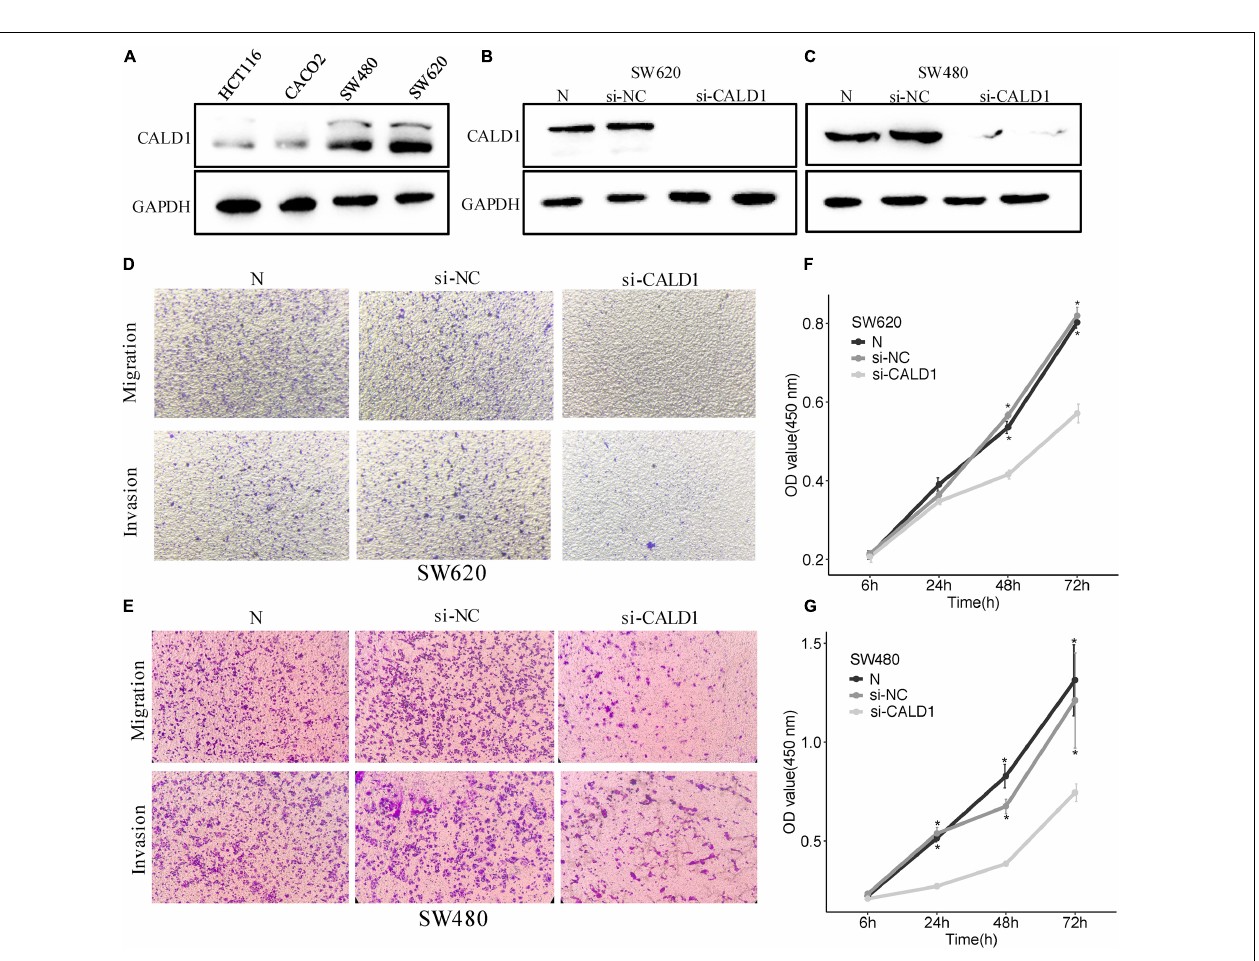
FIGURE 8 | CALD1 promotes cell proliferation, migration, and invasion in CRC cells. (A) The protein levels of CALD1 in four kinds of CRC cell lines were measured by Western blot. (B,C) The protein levels of normal, si-NC, and si-CALD1 transfected SW620 (B) and SW480 (C) cells by Western blot; si-CALD1 transfections were performed in duplicate. (D,E) Transwell assays revealed that CALD1 knockdown attenuated SW620 (D) and SW480 (E) cell migration and invasion. (F,G) CCK8 assays were performed to assess cell viability in normal, si-NC, and si-CALD1 transfected SW620 (F) and SW480 (G) cells. * p < 0.05 in comparison with the si-CALD1 group using Kruskal–Wallis one-way analysis of variance (ANOVA). All assays were repeated at least three